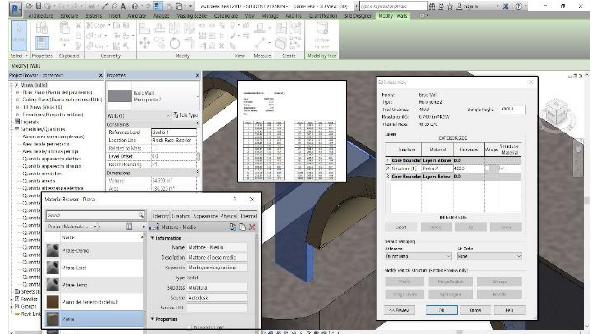
Figure 7. The management of Information System. From Parametric Model (LoD 500) to the integration of stratigraphic information and physical